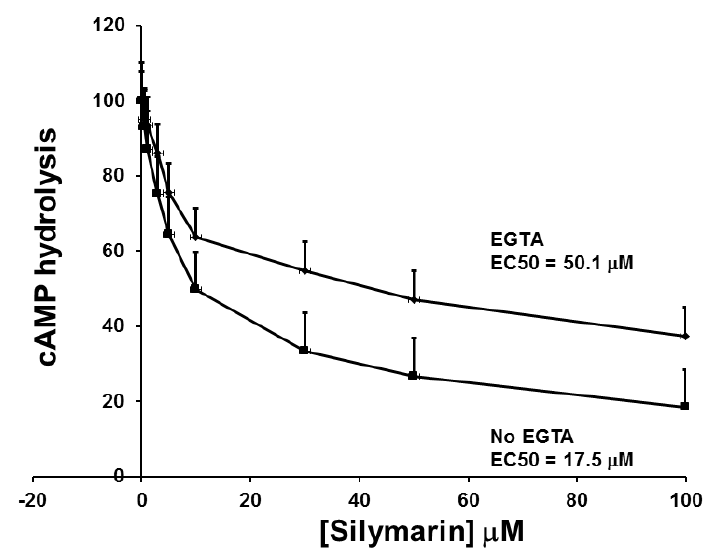
Figure 4. cAMP hydrolysis with increasing concentrations of SIL in the presence of EGTA (a specific chelator for Ca 2+ /calmodulin) and in its absence. A drug concentration-related decrease in cAMP hydrolysis was observed with differing EC 50 values (No EGTA = 17.5 µM; EGTA = 50.1 µM). Data are mean ± SE; experiments performed with n = 3.